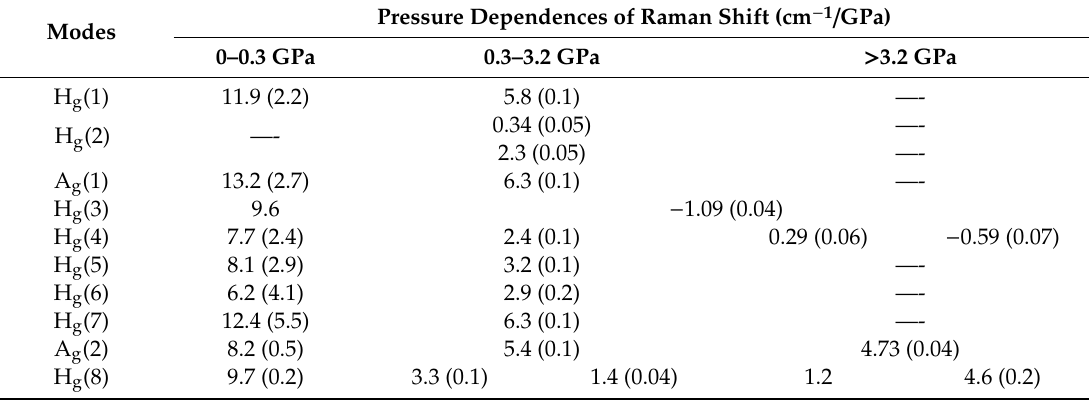
Figure 2. The pressure dependence of the Raman shifts: H g (1), H g (3), A g (1), H g (4), H g (5), H g (8), and A g (2). Table 1. The slopes of Raman shifts of C 60 versus pressure at room temperature.